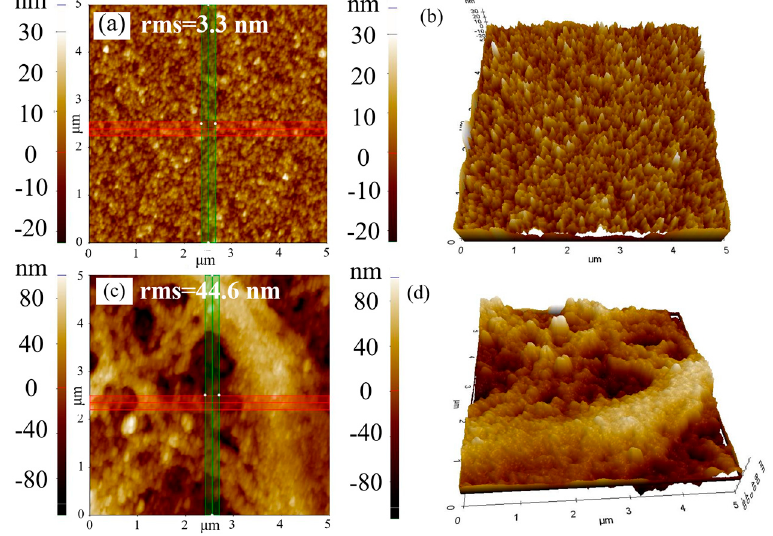
Figure 3. Atomic force microscope (AFM) images of the surface of the TiO 2 layers sprayed by ( a , b ) the w-film; ( c , d ) the d-film using the TiO 2 ethanol solution without TAA.